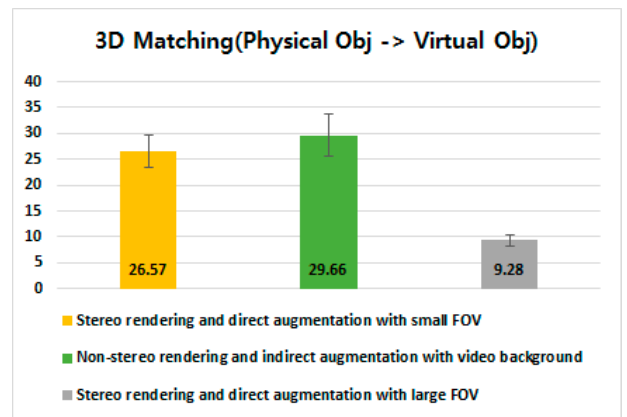
Figure 21. Task completion time (s) for 3D matching from a physical object to a virtual object depending on visual contexts and FOV.